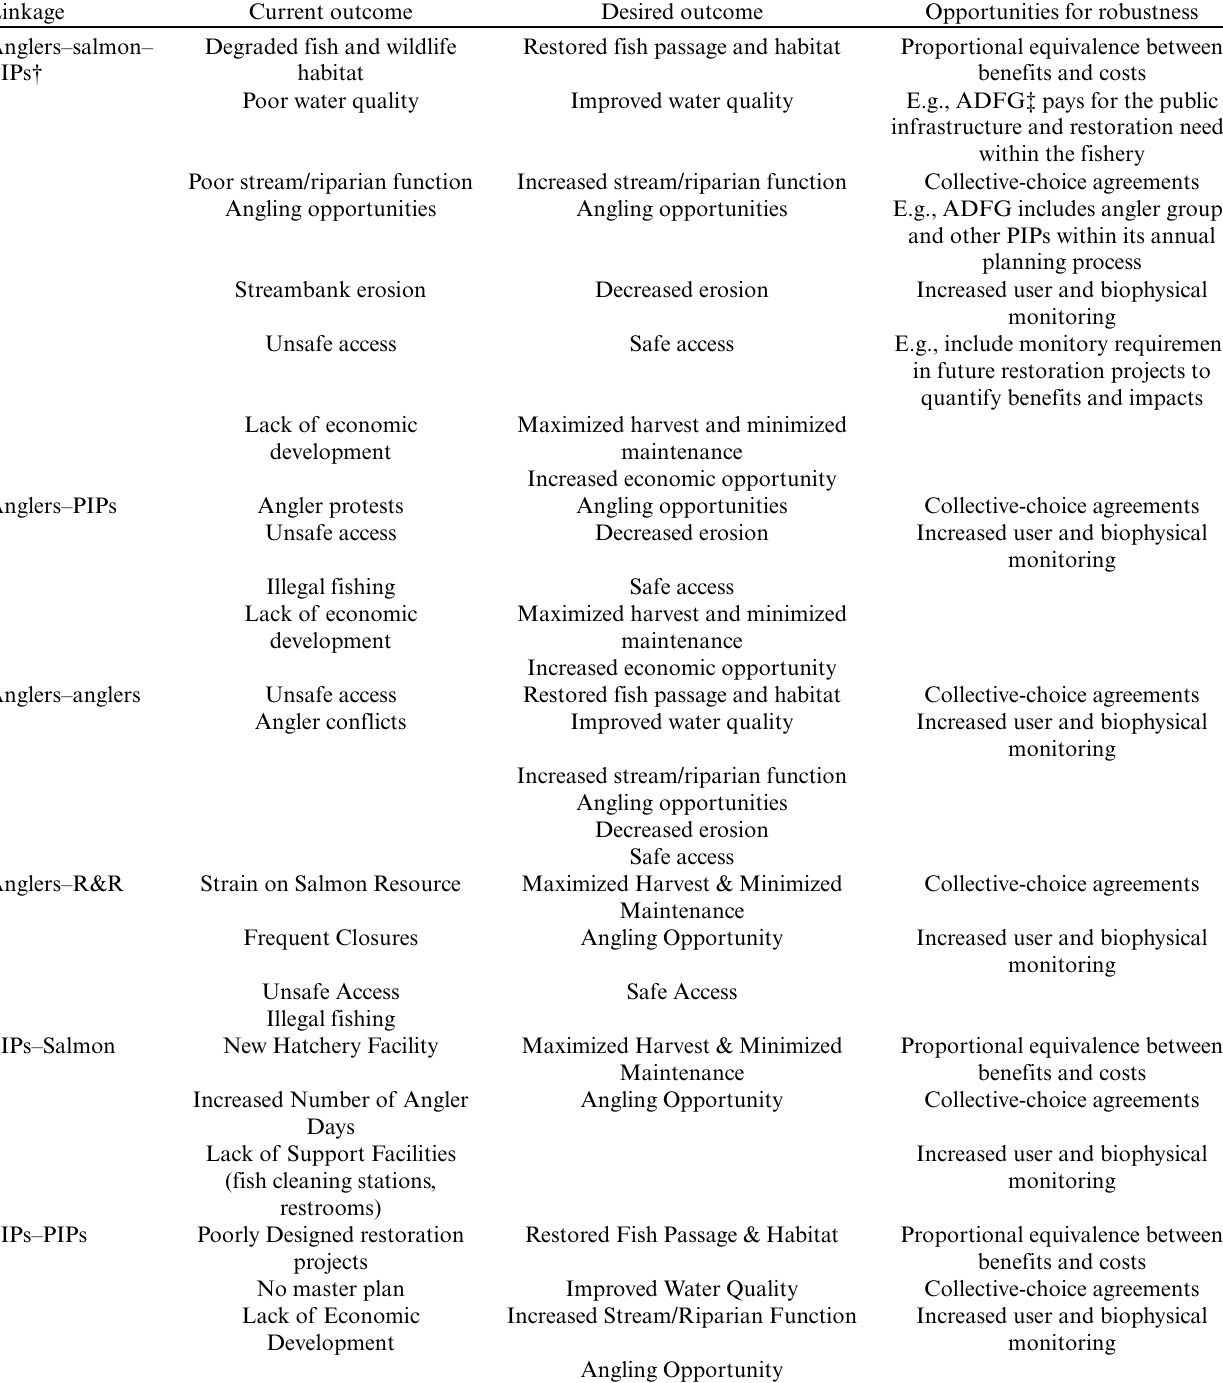
Table 2. Public infrastructure providers’ desired social and ecological components of the lower Ship Creek